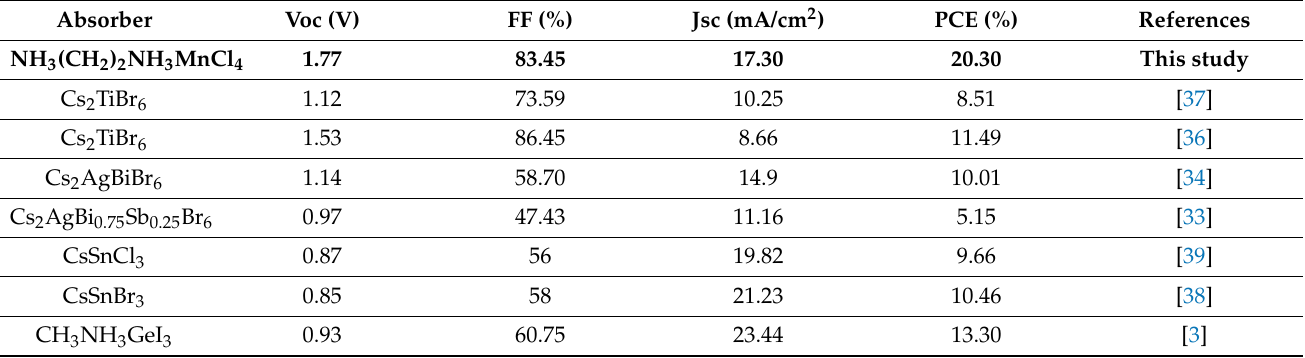
Table 1. Comparison of performance of simulated NH 3 (CH 2 ) 2 NH 3 MnCl 4 ‐ based PSCs with recently published simulated work [3,33,34,36–39].